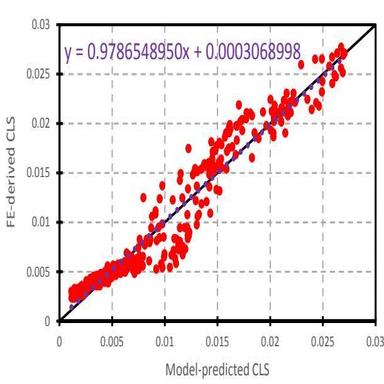
YPT Model prediction vs. FEA.